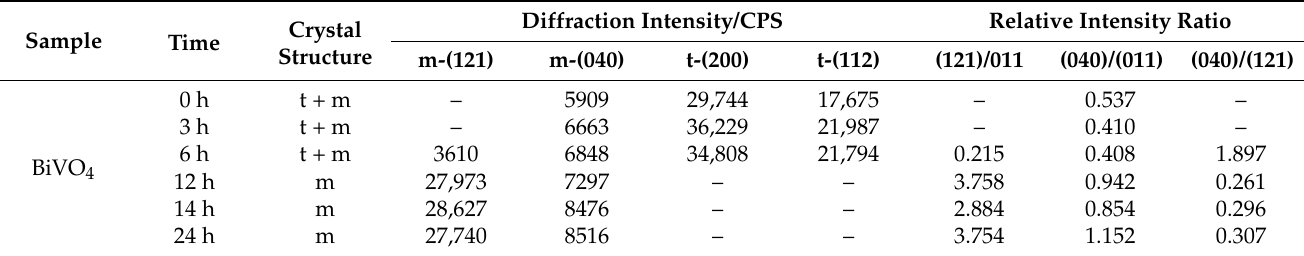
Table 1. XRD microstructure parameters of the BiVO 4 products prepared under different hydrother- mal conditions.